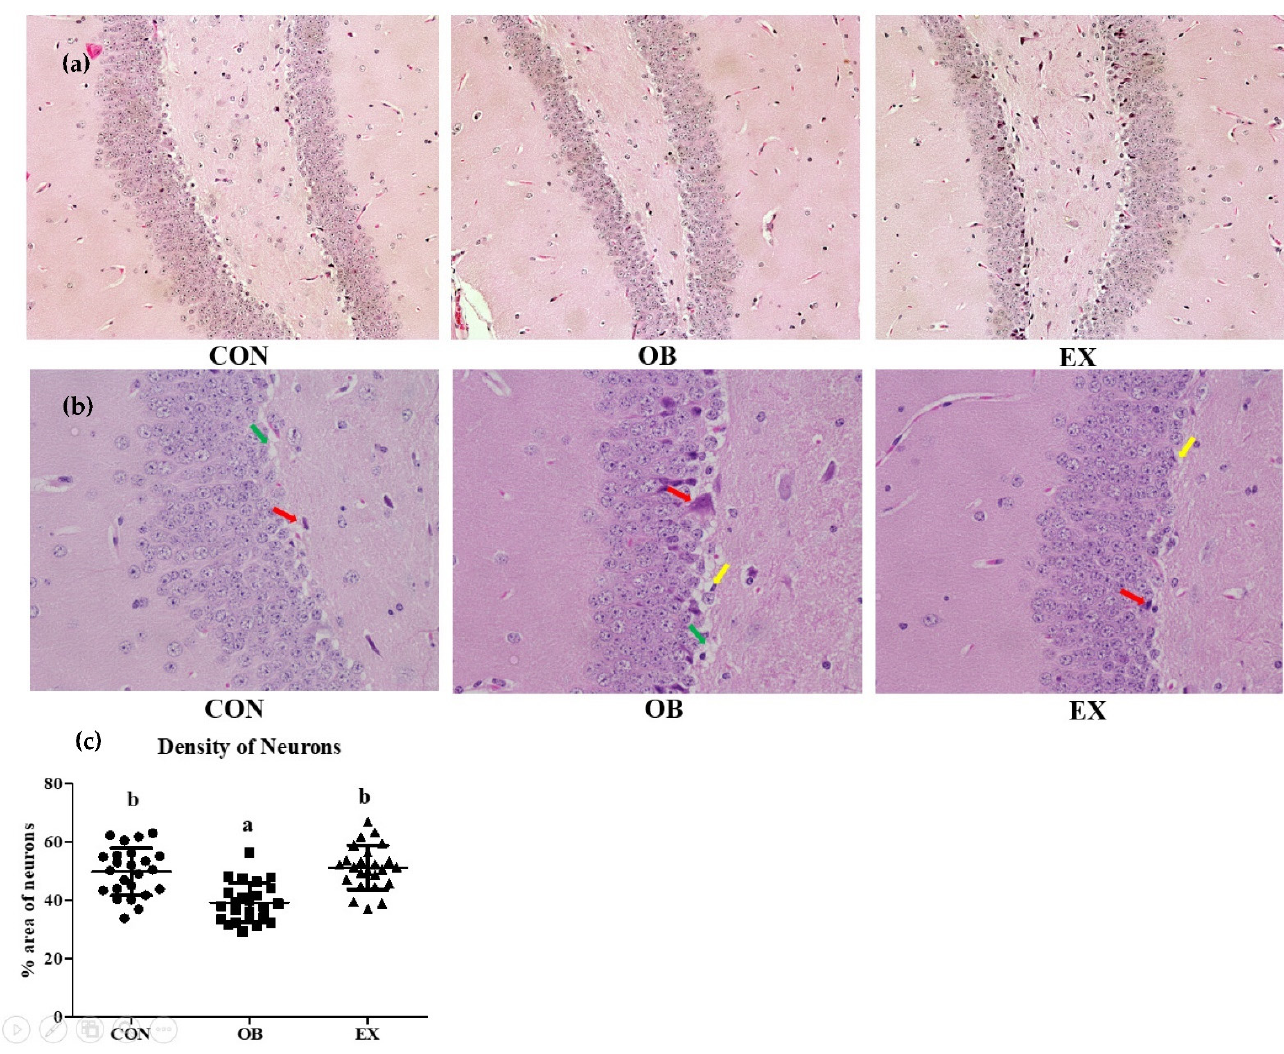
Figure 4. Effects of resistant exercise on the hippocampus (dentate gyrus) morphology in sarcopenic obese mice. ( a ) hippocampus (X200), ( b ) hippocampus (X400), and ( c ) density of neurons. Six random sites were examined. The red arrows represented apoptosis, the green arrows represented vacuolation, and the yellow arrows represented the degradation of neuronal cells. Values are means ± SD ( n = 3~4). Mean values with the same superscript letter (a and b) are not significantly different ( p < 0.05).